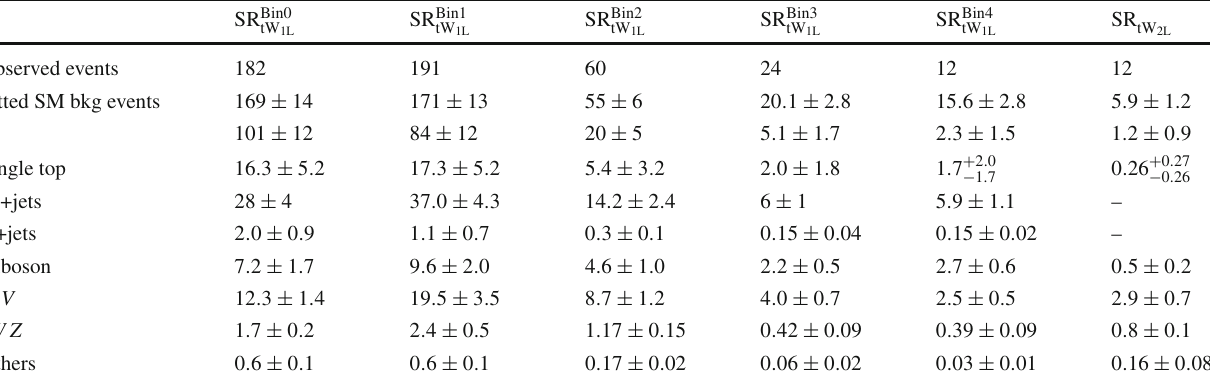
processes, and non-prompt or misidentified leptons background) are grouped and labelled as ‘Others’. The quoted uncertainties of the fitted SM background include both the statistical and systematic